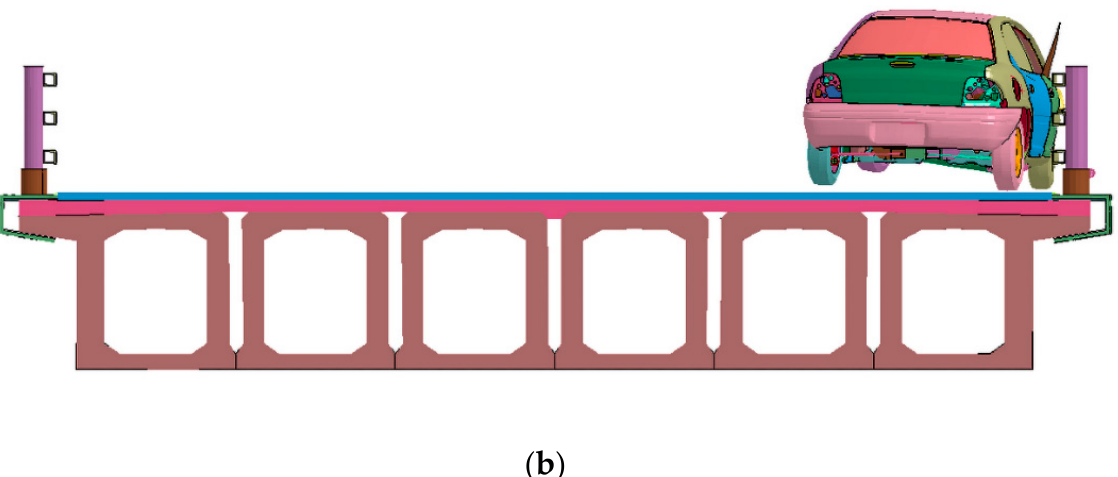
Figure 16. Tilting diagram of the assembled guardrail and car: ( a ) truck tilt chart and ( b ) car tilt chart.